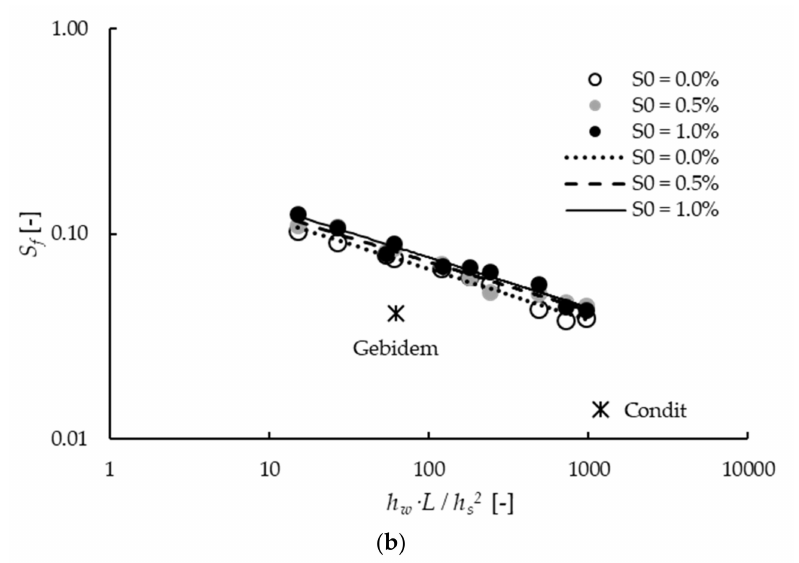
Figure 5. ( a ) Evolution of S f for S 0 = 0.0% and for varying values of h w · L/h s 2 and D * . ( b ) Evolution of S f for medium sand and for varying values of h w · L/h s 2 and S 0